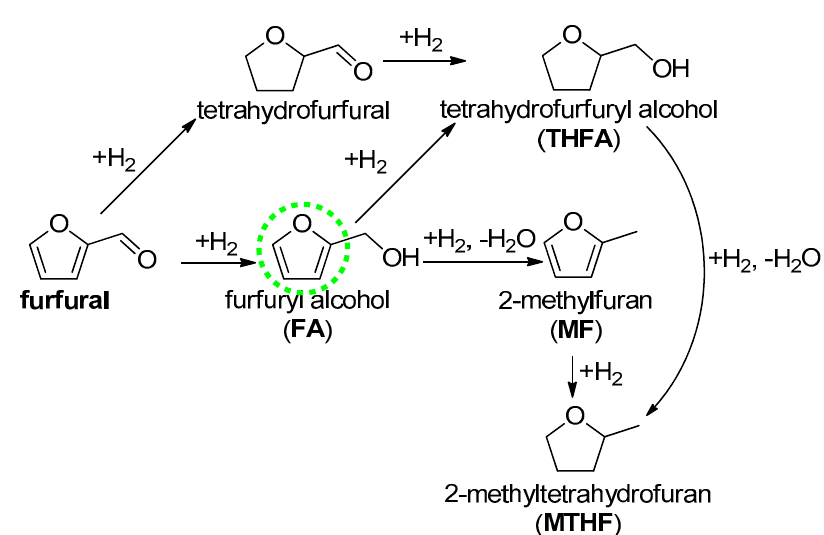
Scheme 1. Illustrative representation of reaction pathways in furfural hydrogenation.